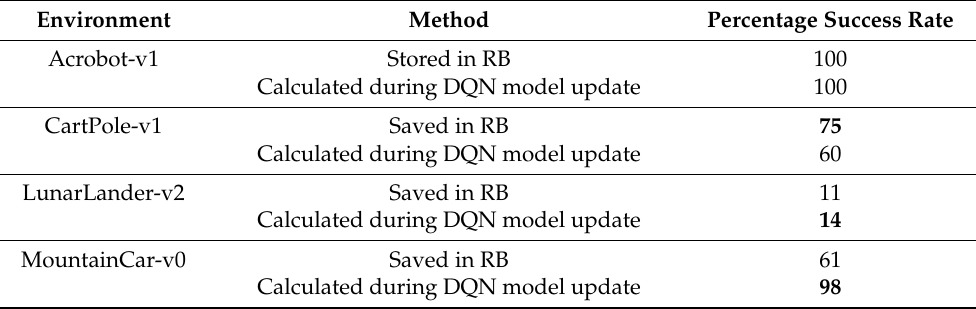
Table 4. Problem-solving success in all tested environments for different methods of updating the intrinsic score. No single method can be considered universally better, as the effectiveness of each method depends on the specific environment. Best results are highlighted in